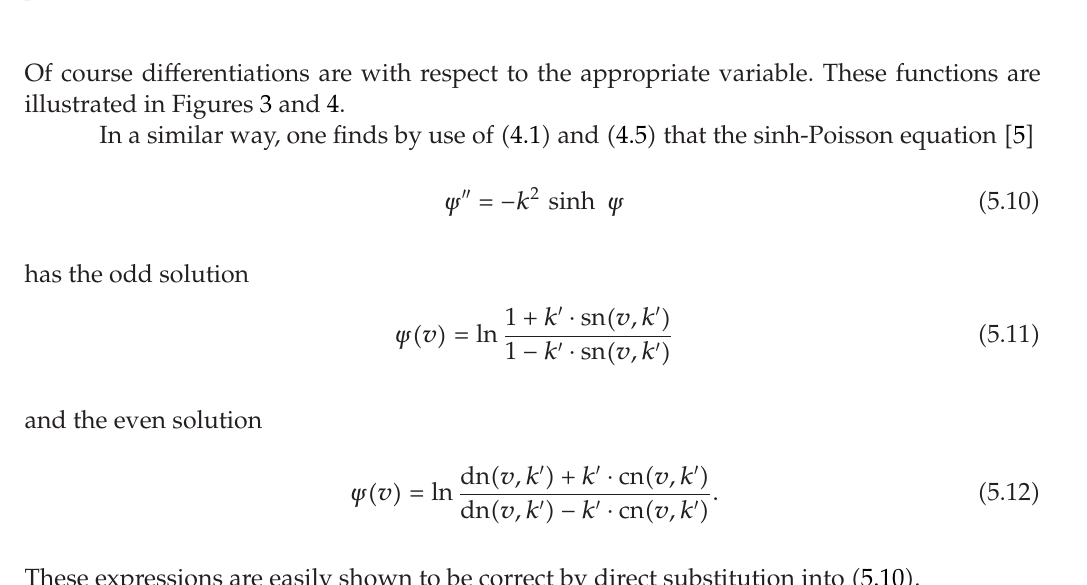
Figure 3: The solution ψ (cid:3) u (cid:4) (cid:8) ln (cid:3)(cid:3) 1 (cid:7) dn (cid:3) u,k (cid:4)(cid:4) / (cid:3) 1 − dn (cid:3) u,k (cid:4)(cid:4)(cid:4) for the Poisson Boltzmann equation. The parameters are k 2 (cid:8) 0 . 75 and K (cid:8) 2 .